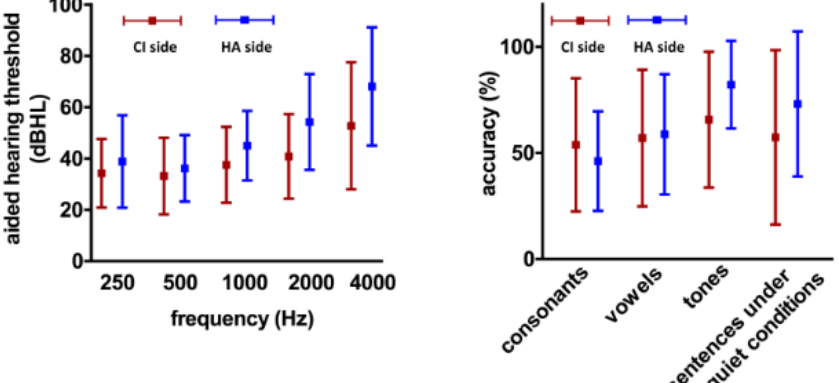
Figure 1. The characteristics of AHT and SPA in cochlear and HA sides of 49 CI subjects. Among the 49 CI patients (unilateral implantation/bilateral implantation/dual mode, cochlea with HA), 55 ear sides wore CI, and 16 ear sides wore HAs.